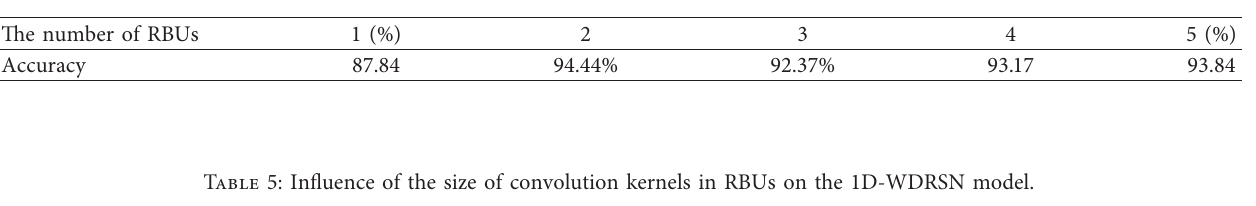
Table 4: Influence of the number of RBUs on the 1D-WDRSN model.